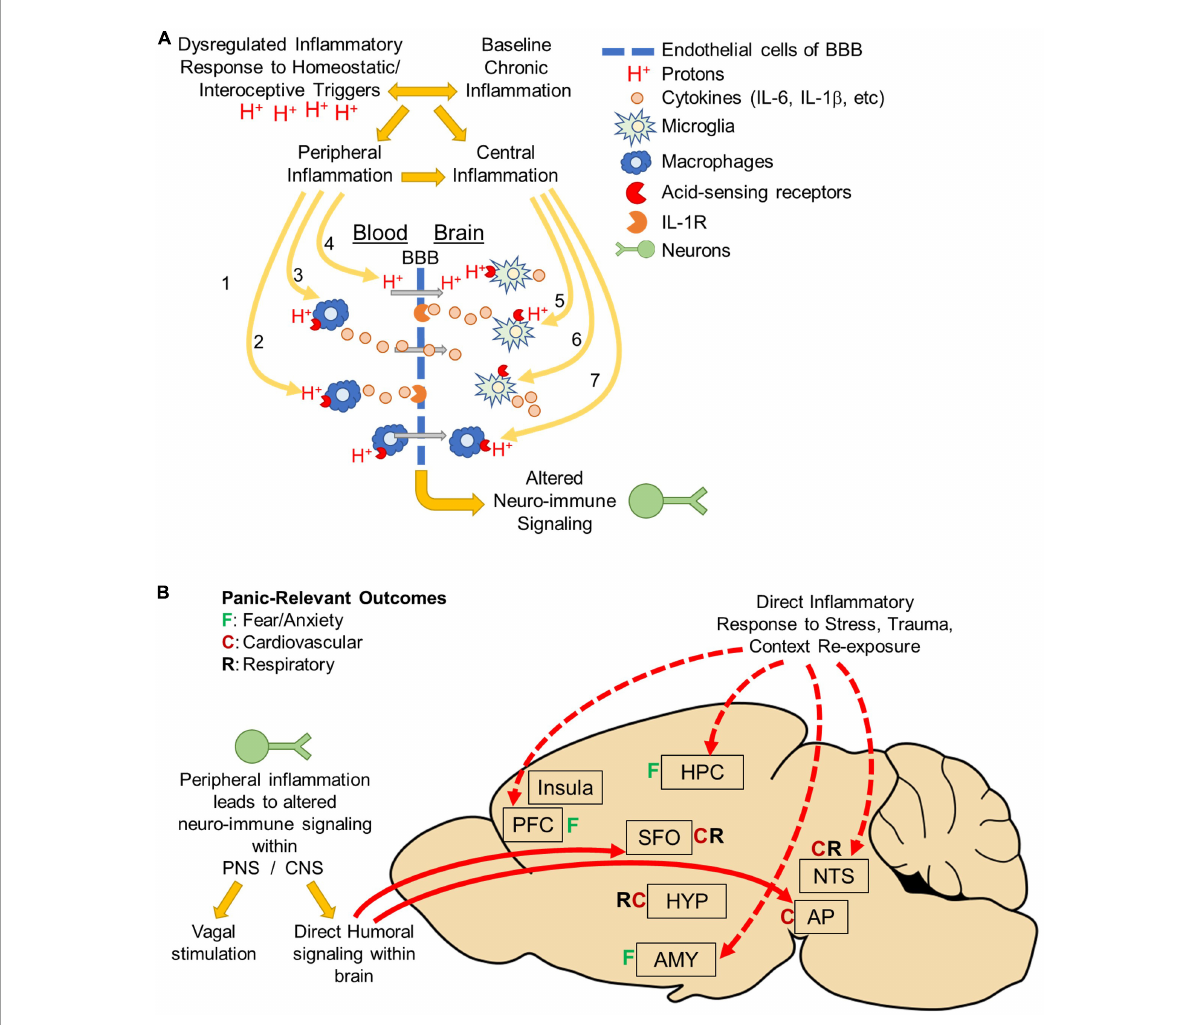
FIGURE2 Body to brain signaling: Mechanisms of acidosis evoked peripheral and central inflammation: (A) panic disorder is associated with dysregulated inflammatory responses to homeostatic/interoceptive triggers like acidosis. Panic disorder is also associated with baseline chronic inflammation. Regardless of which inflammatory response occurs initially, either can facilitate the development of the other and result in peripheral and central inflammation. Acidosis could lead to altered neuroimmune signaling through a variety of mechanisms. In the periphery, acidosis may activate acid-sensing receptors on peripheral macrophages. This could lead to either (1) macrophage infiltration across the blood brain barrier (BBB), (2) cytokine release that activates cytokine receptors on endothelial cells, or (3) release of cytokines that cross the BBB. Peripheral acidosis could acidify the brain via protons (H + ) that cross the BBB and activate acid-sensing receptors on microglia. Alternatively, acidosis could occur directly within the brain (5) activating acid-sensing receptors on microglia resulting in cytokine release and activation of cytokine receptors on endothelial cells or (6) directly on neurons or other cell types. It is also possible that acidosis could activate acid-sensing receptors on peripheral macrophages that have previously infiltrated the brain, possibly as a result of prior trauma or other risk factor (disease, etc.). Ultimately, Inflammation within the brain is thought to drive emotional, behavioral and physiological responses that occur during panic attacks and increase vulnerability to develop panic disorder. (B) Peripheral inflammation can alter neuronal activity either by neuro-immune signaling occurring either in the periphery or directly in brain. In the periphery, neuro-immune signaling could result in vagal stimulation that terminates in the nucleus tractus solitarius (NTS) and mediates cardiovascular and respiratory responses. There could also be direct humoral signaling within circumventricular organs the subfornical organ (SFO) or Area Postrema (AP). These areas are known to project directly to fear, respiratory and cardiovascular regulatory areas throughout the brain. Alternatively, inflammation could occur directly in the brain in response to stress (interoceptive/homeostatic or exteroceptive), trauma, or panic context re-exposure. Many studies have shown increased inflammation in fear-associated regions prefrontal cortex (PFC), hippocampus (HPC), amygdala (AMY) or the NTS. Inflammation in these areas could affect neuronal activity and drive the emotional, behavioral and physiological responses associated with panic disorder